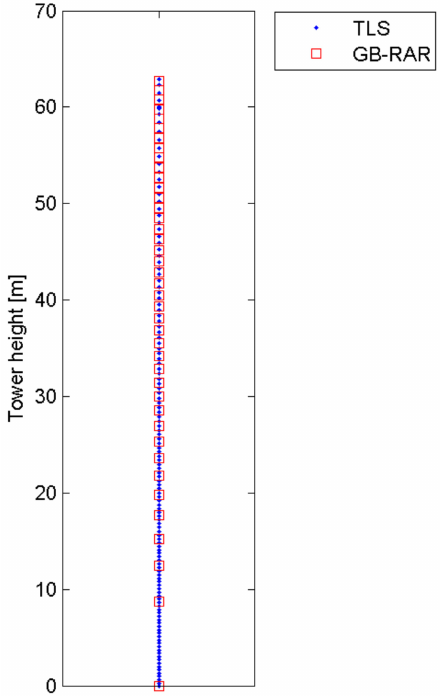
Figure 4. TLS ( blue dots ) and GB-RAR ( red square ) measurement points along the wind tower. The range distance and resolution of each GB-RAR measurement point is given by Equation